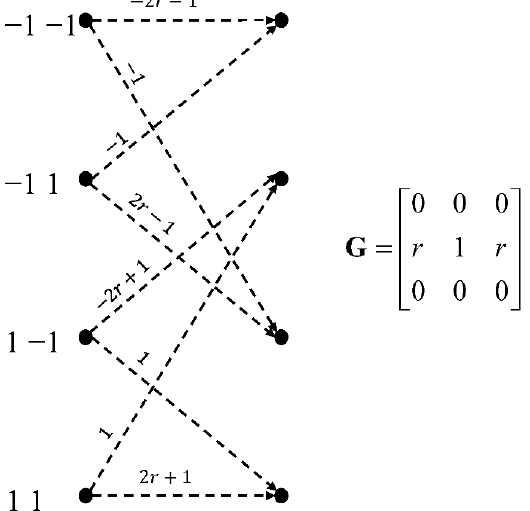
Figure 3. Trellis for the detection of the 2-way GPR target.